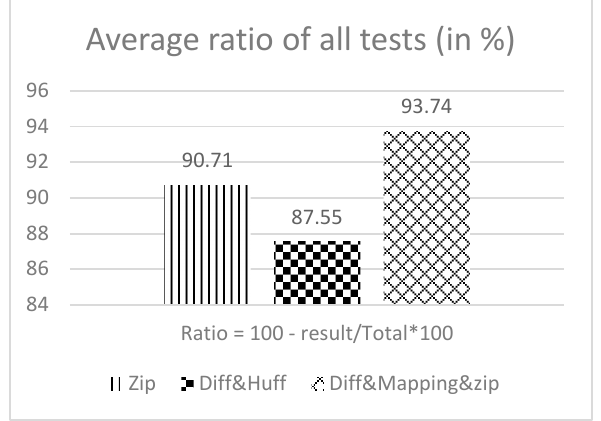
Figure 5. Average ratio between compression methods (percentages ).